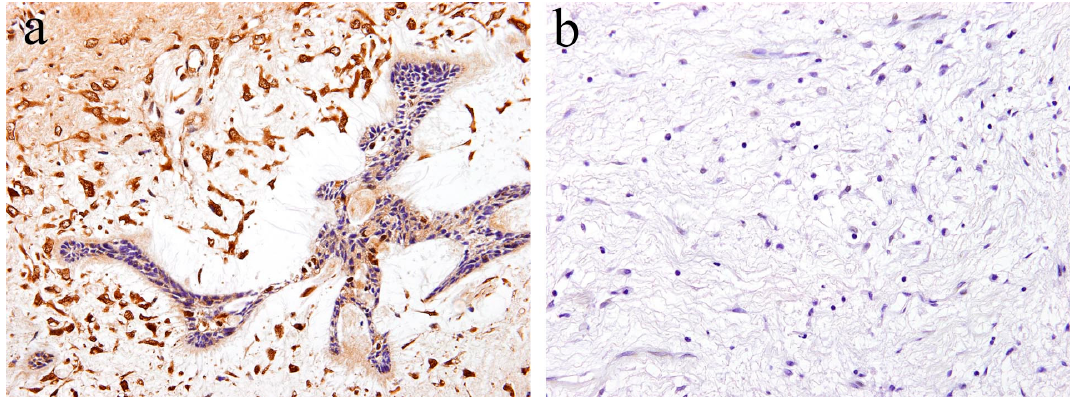
Figure 4. Immunohistochemical features of Notch1 expression. ( a ) Notch-positive reactions are observed in ameloblastic fibroma. Magnification ×100. ( b ) Notch expression is not observed in the tumor tissue of odontogenic myxoma. Magnification ×100. Anti-Notch-1 intracellular domain antibody, Abcam, ab83232,